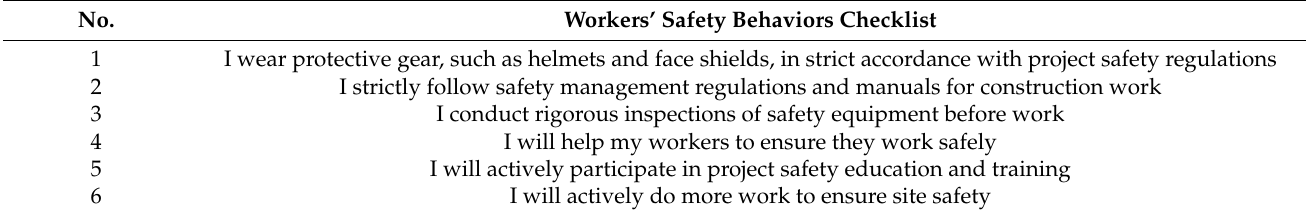
Table A2. Workers’ safety behaviors